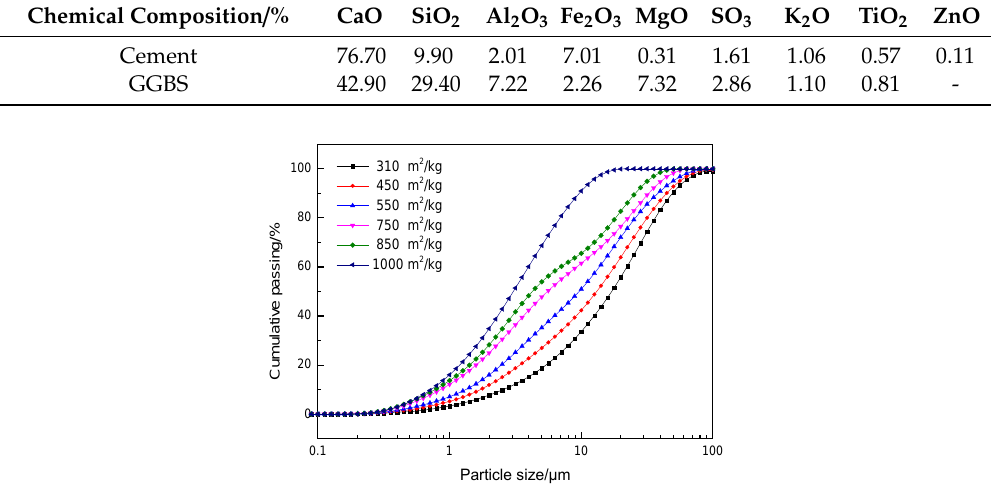
Table 1. Chemical composition of cement and GGBS / mass, %.